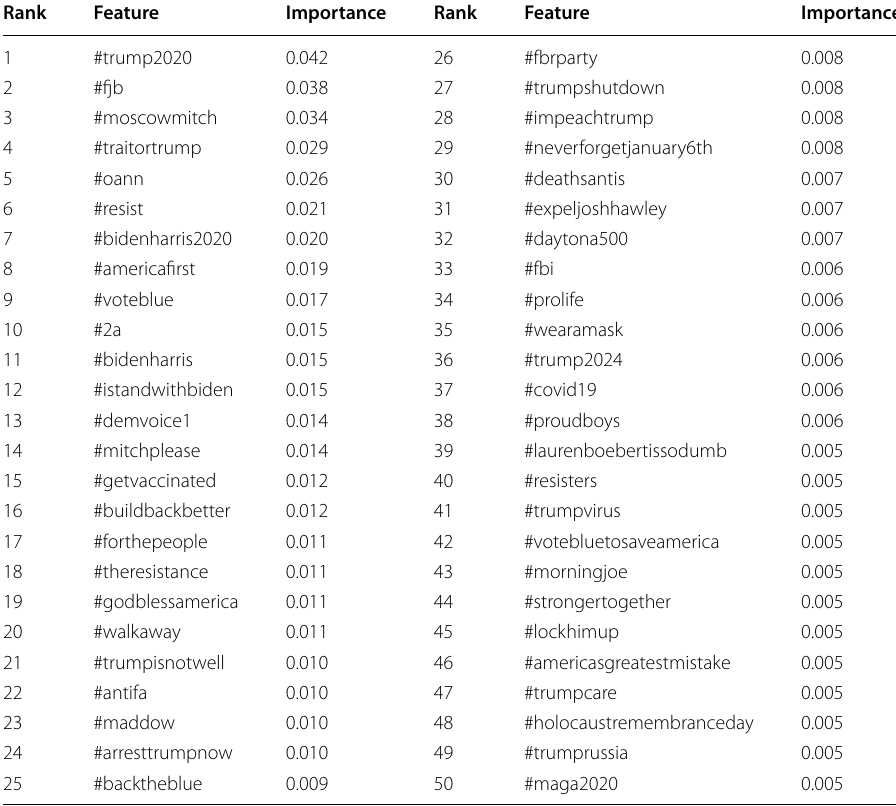
Table 8 Top‑50 important features for the best performing political orientation classifier using the Random Forest